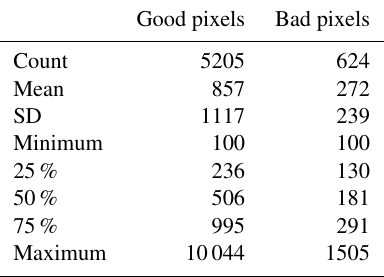
Table A1. Statistics of pixels with and without valid thickness. Numbers represent speed (myr − 1 ) except for the “count” row.